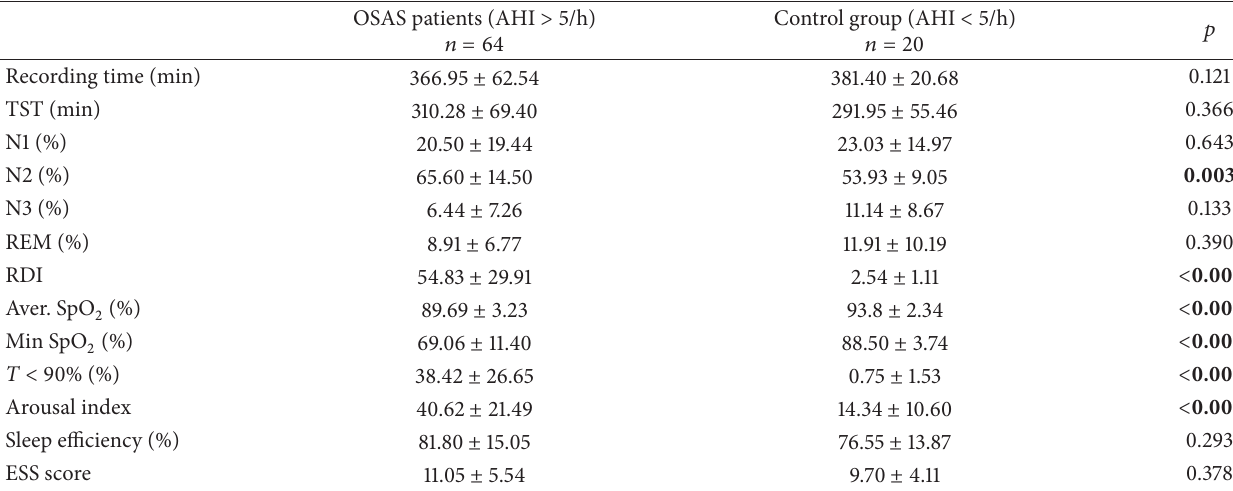
Table 2: Comparison of sleep characteristics between OSAS patients and